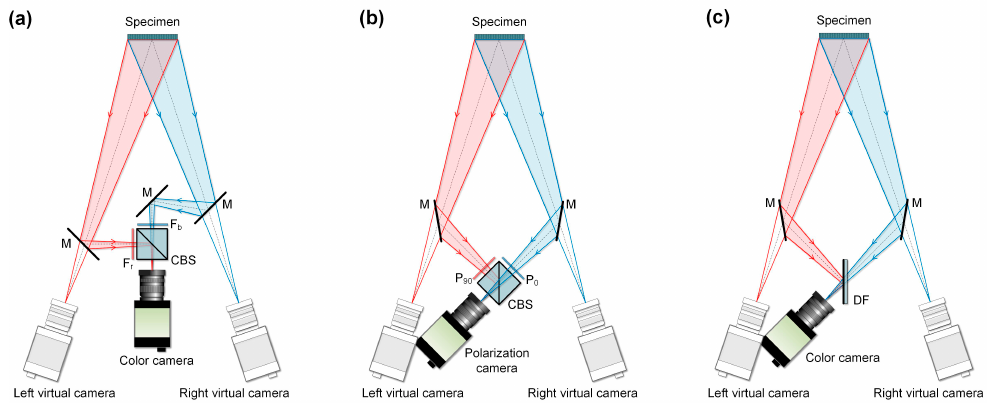
Figure 1. Optical arrangements of ( a ) color separation device-assisted single-camera stereo-digital image correlation (stereo-DIC), ( b ) polarization-based single-camera stereo-DIC, ( c ) dichroic filter-aided single-camera stereo-DIC. M: Mirror, CBS: cube beam splitter, F b : blue bandpass filter, F r : red bandpass filter, P 90 : 90° polarizer, P 0 : 0° polarizer, DF: dichroic filter.